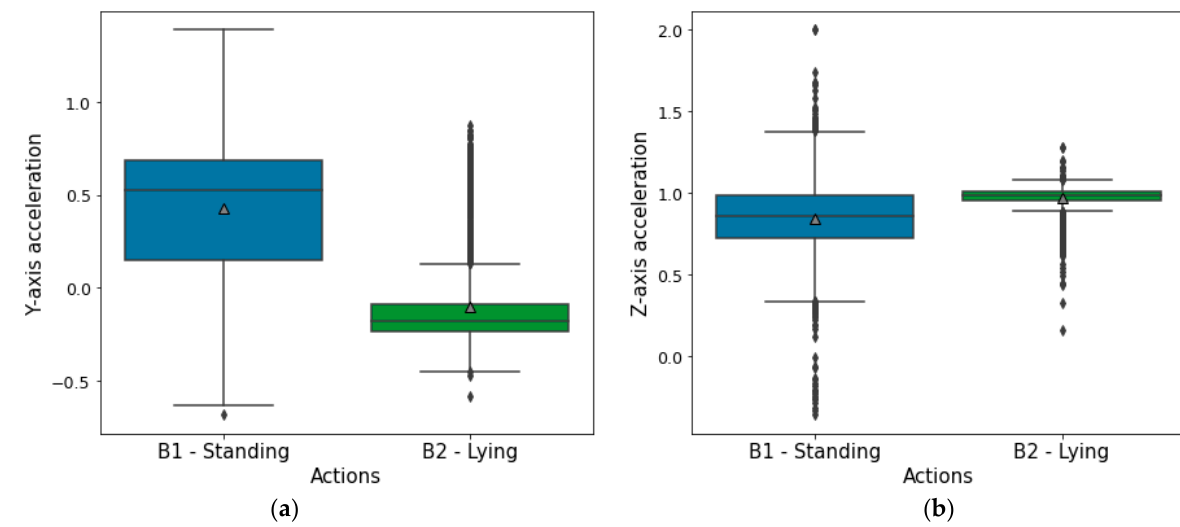
Figure 7. Y-axis and Z-axis accelerometer signal distribution while standing and lying of all data annotated with standing and lying postures. ( a ) Y-axis; ( b ) Z-axis.